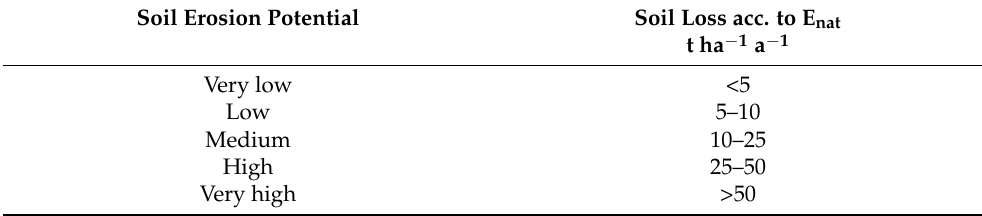
Table 3. Assignment of calculated soil losses (E nat ) to classes of erosion potential. Soil Erosion Potential